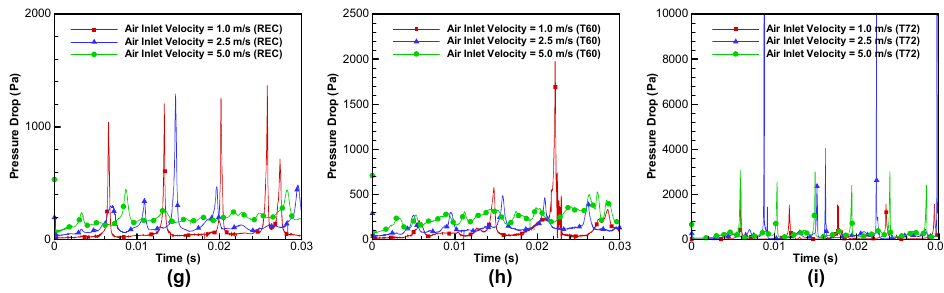
Figure 8. Effect of the air inlet velocity on the time evolution of ( a ) WVF (REC); ( b ) WVF (T60); ( c ) WVF